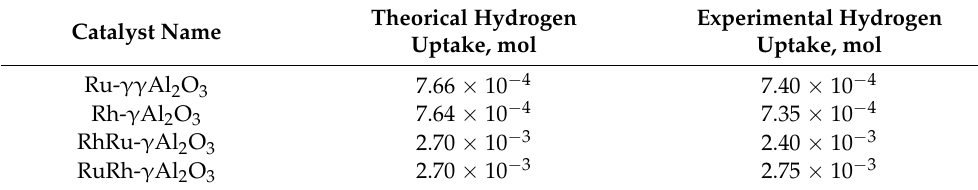
Table 2. Catalysts’ theoretical and experimental H 2